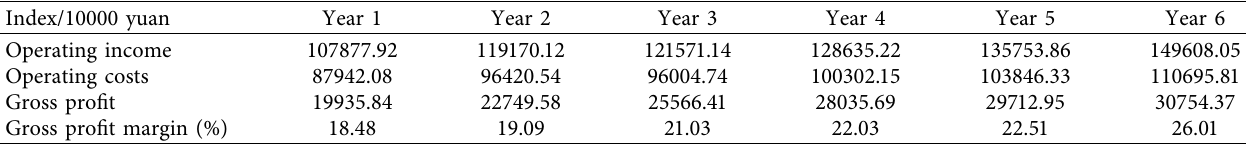
Table 9: Business indicators of logistics